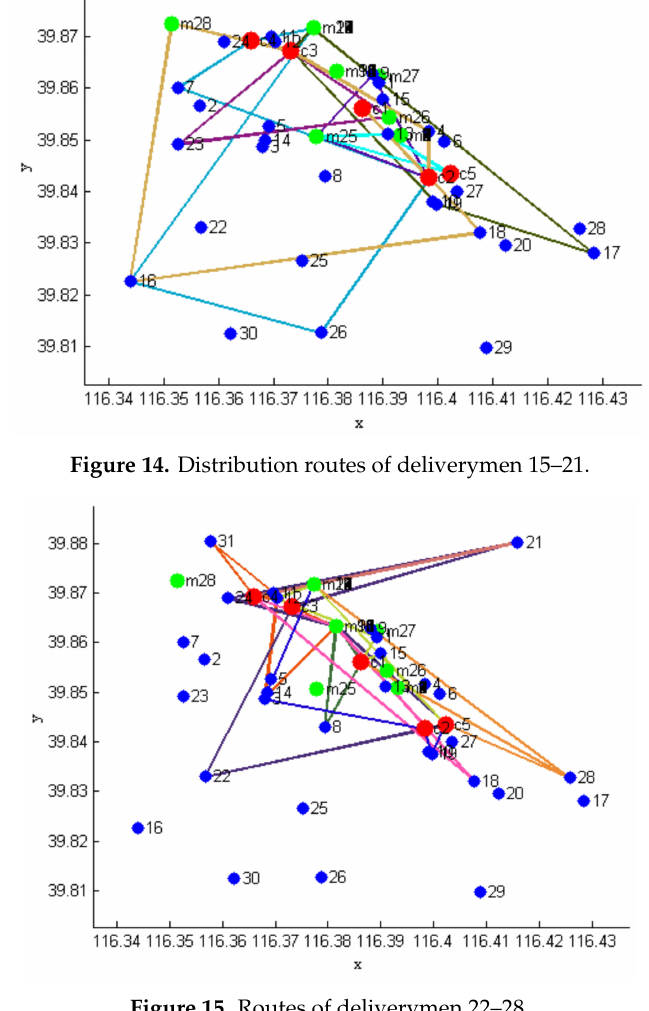
Figure 15. Routes of deliverymen 22–28.